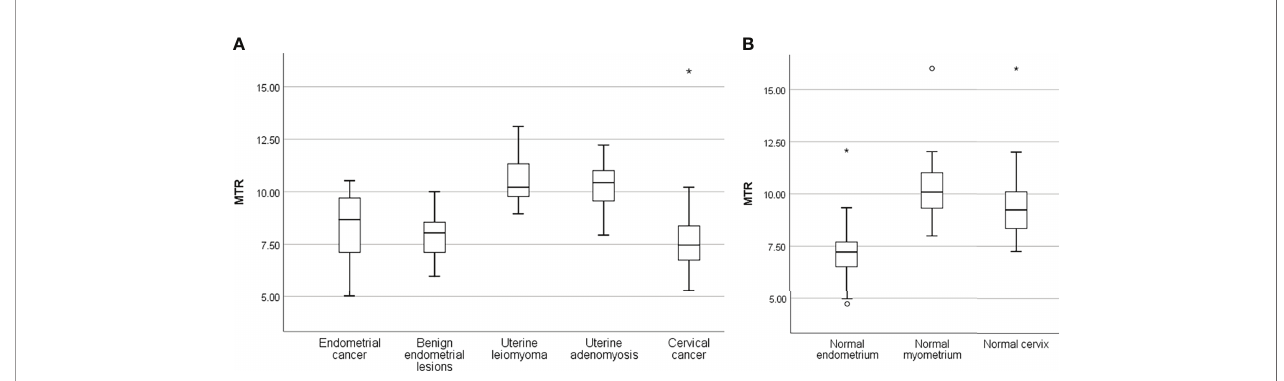
FIGURE 3 | Box plots show the distribution of MTR in uterine lesions (A) and normal uterine structures (B) . The lines of box plot present the minimum, the lower quartile, the median, the upper quartile, and the maximum, respectively; the length of whiskers and the position of the line in the box suggest the distribution of sample; circle, outliers;